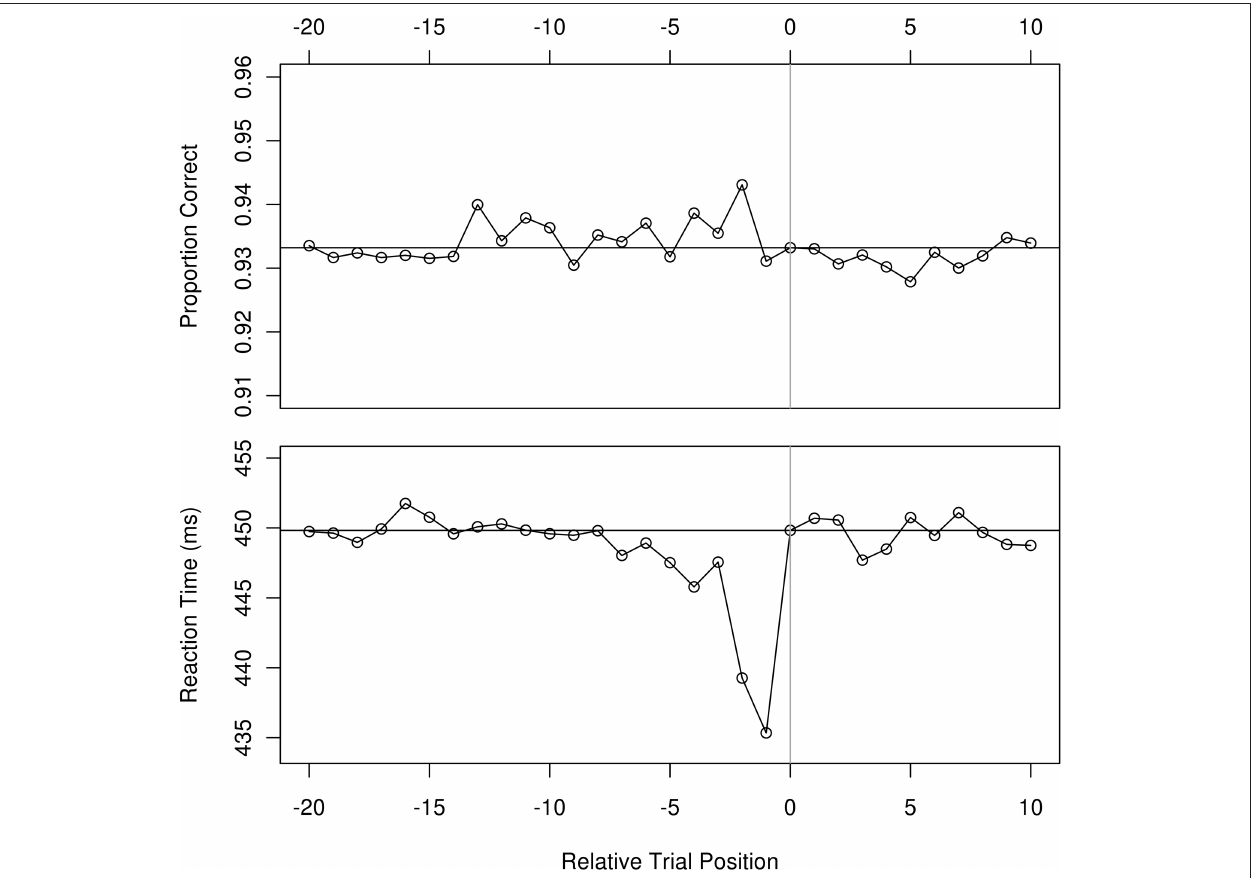
corresponding horizontal lines. A future stimulus cannot prime a current one, so the future trial contingencies serve as a visual reference for variability in the